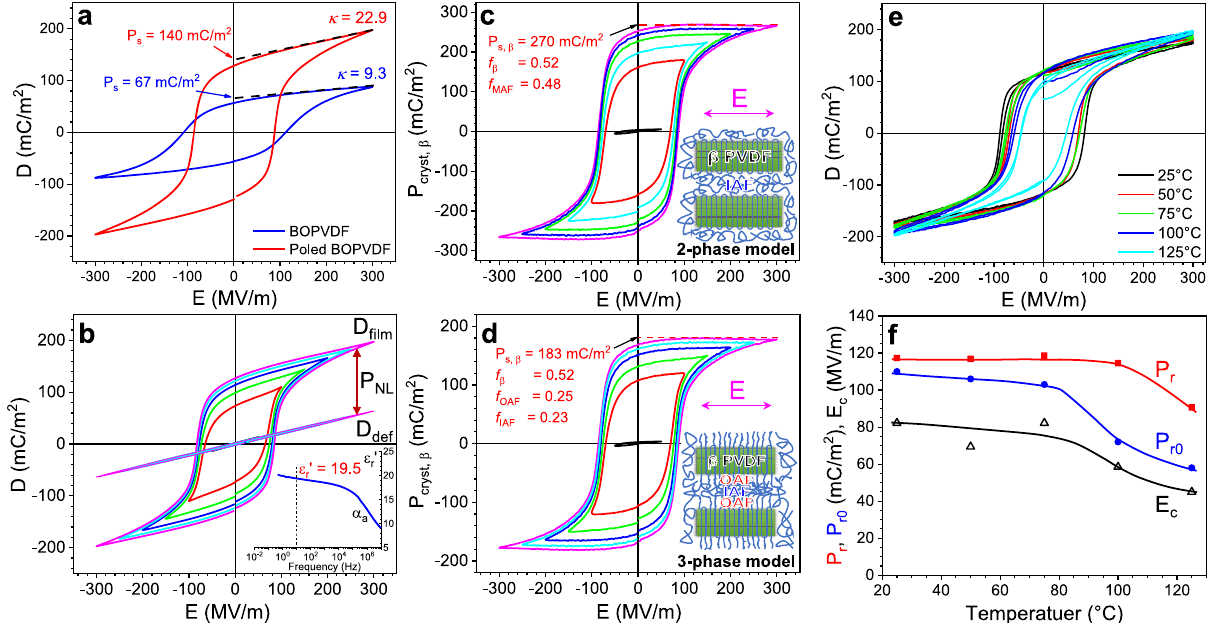
Fig. 2 Ferroelectric property of the poled BOPVDF. a Comparison of the bipolar D-E loops for the fresh and poled BOPVDF fi lms at 300 MV/m. b Progressive bipolar D-E loops for the poled BOPVDF under different electric fi elds at room temperature. The poling fi eld has a sinusoidal waveform at 10 Hz. The inset shows the frequency-scan real part of the relative permittivity ( ε r ′ ) at 25 °C. The extracted linear D-E loops from the deformational polarization (D def ) of the poled BOPVDF fi lm are also shown, following the method in a previous report (see Supplementary Note 3) 19 . After subtracting the D def loop from the bipolar D-E loops for the poled BOPVDF fi lm, nonlinear P-E loops are obtained for c the two-phase and d the three-phase models. The inset two-phase model in c contains the β lamellar crystals and the isotropic amorphous fraction (IAF). The inset three-phase model in d contains the β crystals, the IAF, and the oriented amorphous fraction (OAF) connecting the lamellar crystal and the IAF. e First two consecutive bipolar D-E loops for the highly poled BOPVDF fi lm after thermal annealing at different temperatures for 30 min. f Determination of instantaneous P r , permanent P r0 , and E c from the bipolar D-E loops in e for the highly poled BOPVDF at different